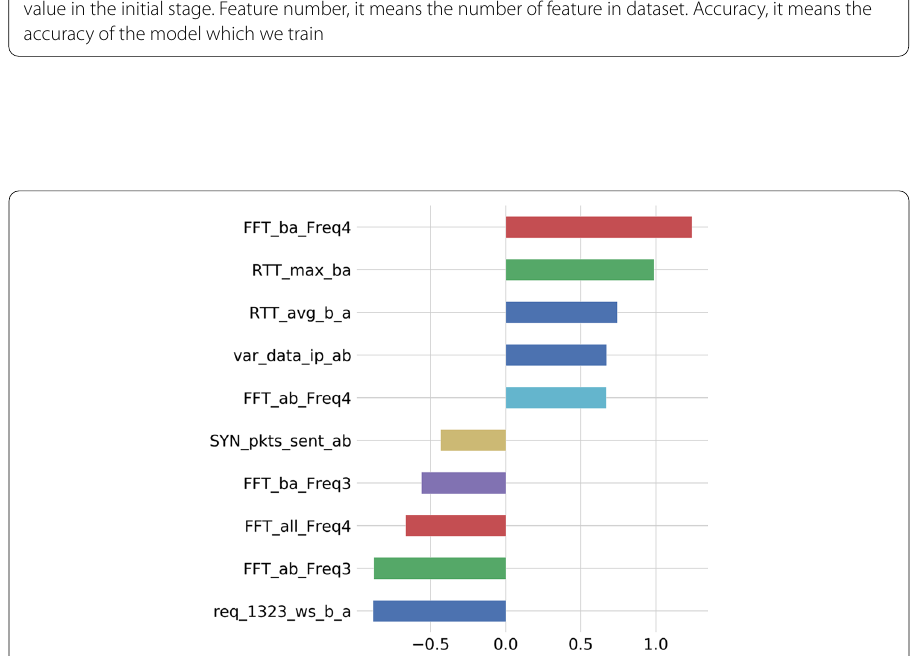
Fig. 5 Coefficients in the Lasso Model. X -coordinate, it shows weight coefficient under optimal regularization parameters. Y -coordinate, it shows features which weight coefficient large than